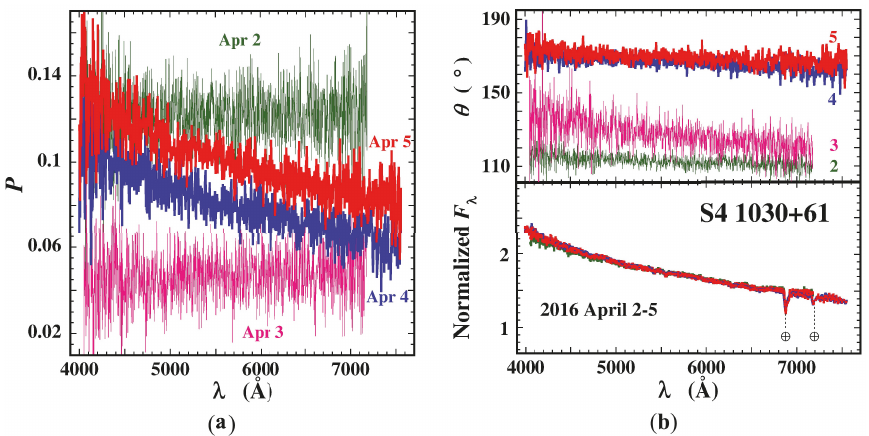
Figure 6. Observations of S4 1030+61 while the blazar was undergoing a period of strong optical and γ -ray activity. ( a ) Pronounced variability in polarization and in how P changes with wavelength is seen over a period of four consecutive nights; ( b ) Strong variability in θ and its wavelength dependence are shown ( upper panel ) along with the stable optical spectral index ( lower panel ) observed during this period. The optical flux spectra have been normalized in the